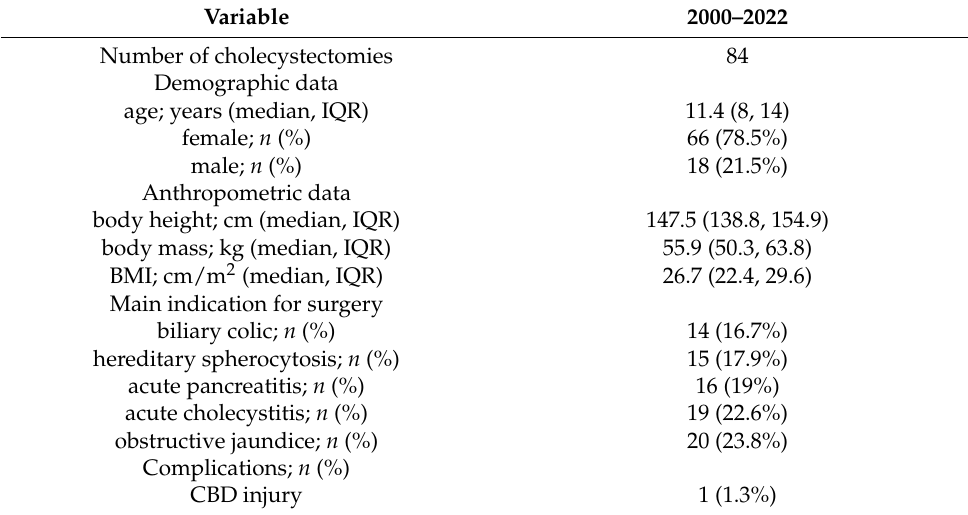
Table 1. Demographic and clinical characteristics of children who underwent cholecystectomy dur- ing the study period.